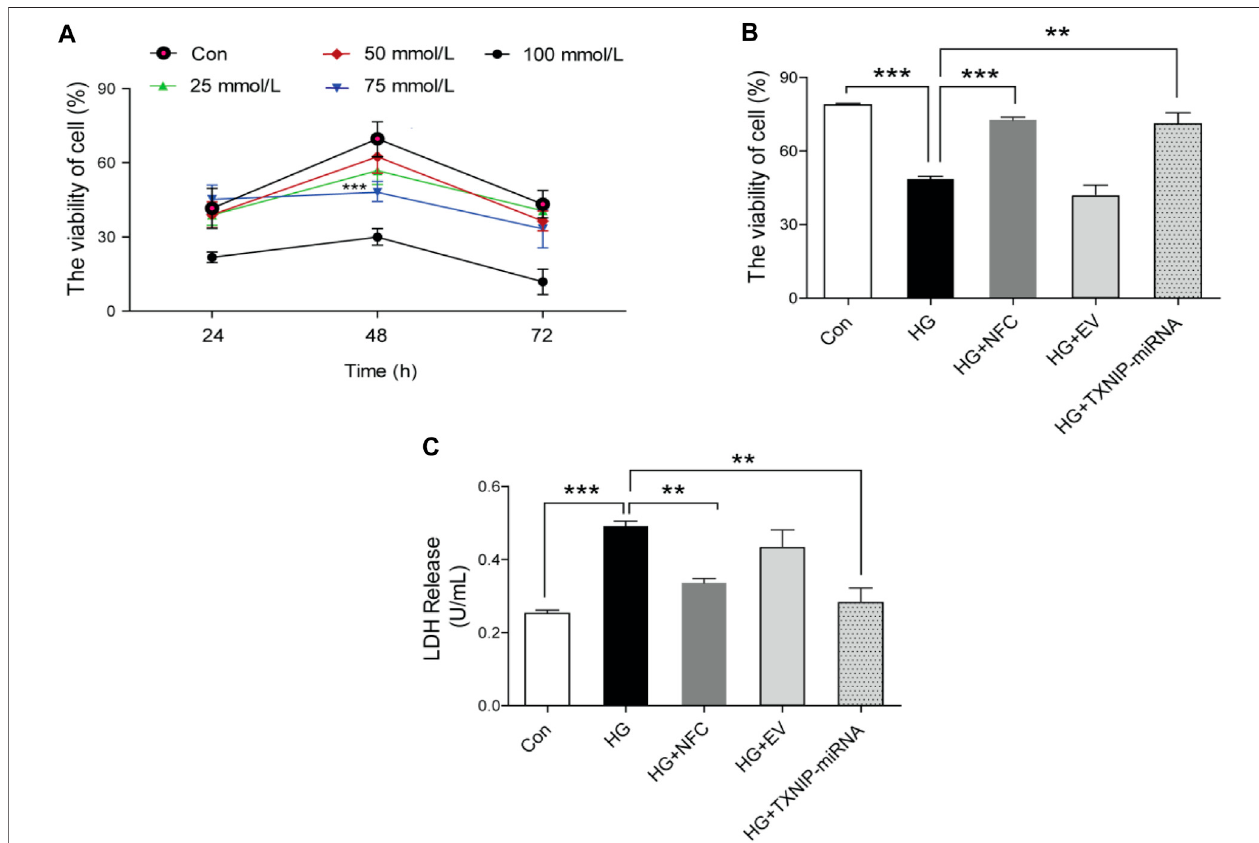
FIGURE1| Naofucongreducedhighglucose-inducedHT22hippocampalneuroncelldamage. (A) TheactivityofHT22cellsculturedwithhighglucoseatdifferent concentrations and at different time points, *** p < 0.001, 75 mmol/L vs. Con. (B, C) HT22 cell activity and LDH release level under high glucose conditions (75 mmol/L and 48 h), NFC or lentivirus knockout of TXNIP treatment. Values are means ± SEM, n (cid:2) 5 per group, * p < 0.05, ** p < 0.01, *** p <